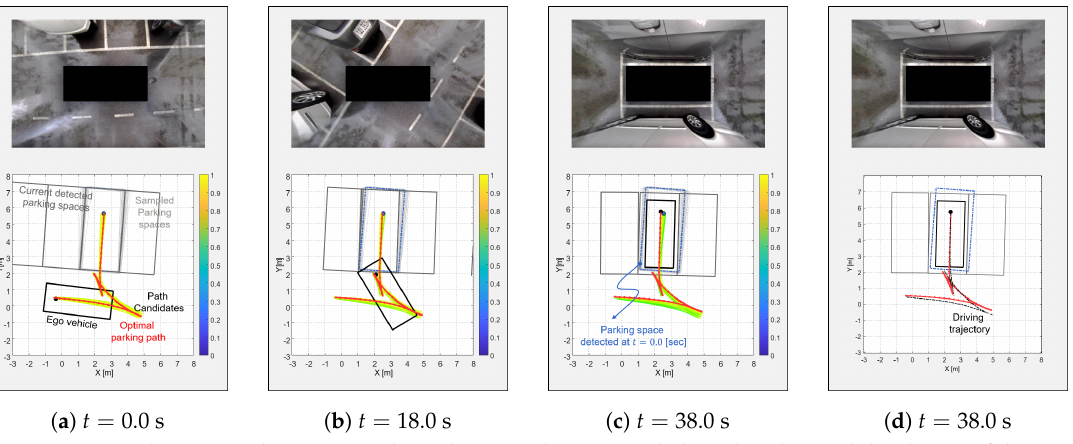
Figure 14. The occupied scenario with re-planning; the proposed algorithm detected the change of the parking space, then, changed its optimal path to locate the vehicle in the actual parking